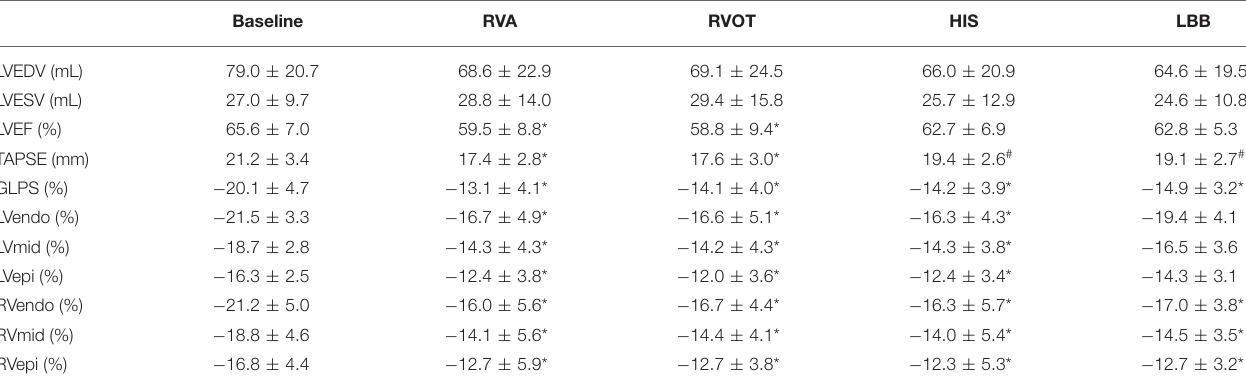
TABLE 2 | Comparison of the acute change of different pacing sites on cardiac